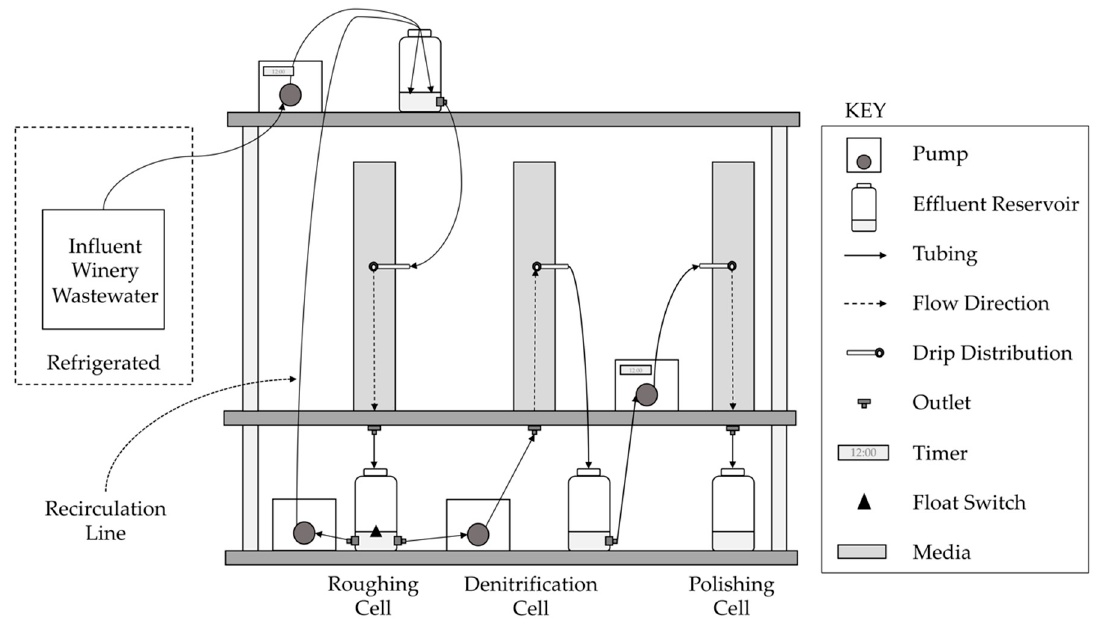
Figure 1. Bench-scale experimental subsurface vertical flow constructed wetland (SVFCW) system.